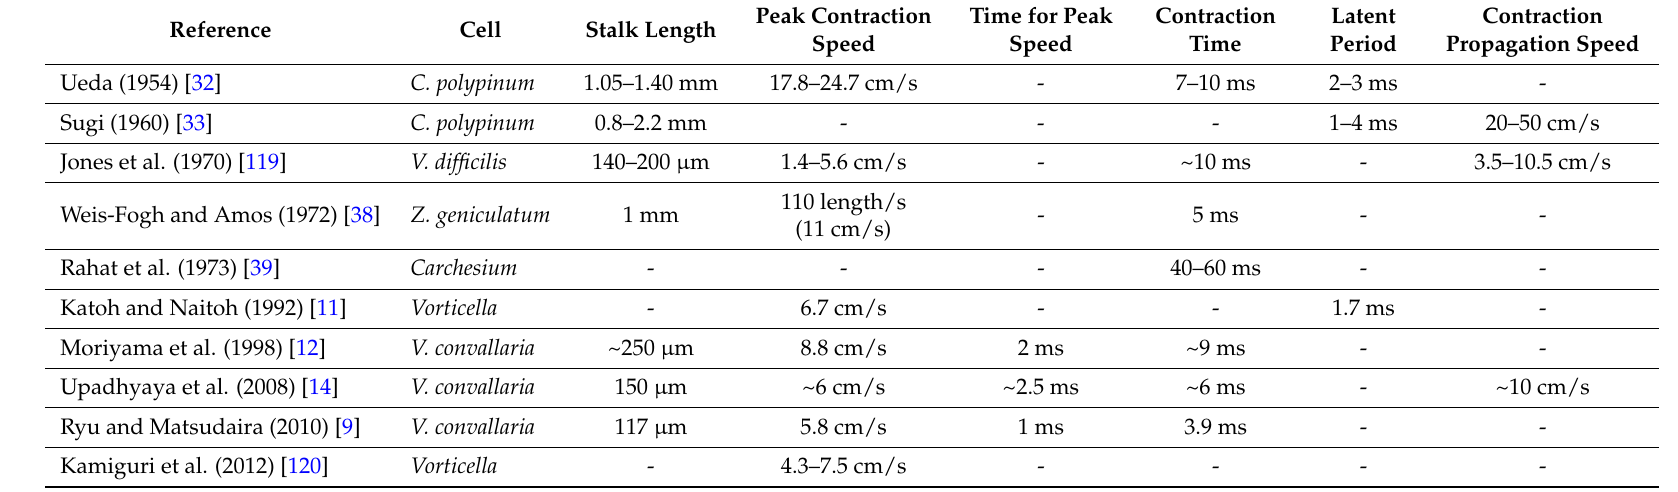
Table 1. Key dynamics parameters of the stalk contraction of live Vorticella and its relatives (in